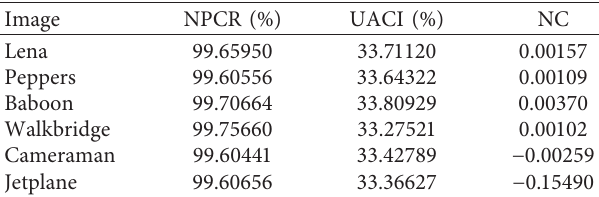
Figure 6: Key sensitivity test applied on the plain image: (a) encrypted original Lena, (b) encrypted modified Lena, (c) difference between (a) and (b), (d) decrypted (a) by key K i 1 , (e) decrypted (b) by key K i 2 , and (f) difference between (d) and (e). Table 8: NC, NPCR, and UACI tests applied on the image.